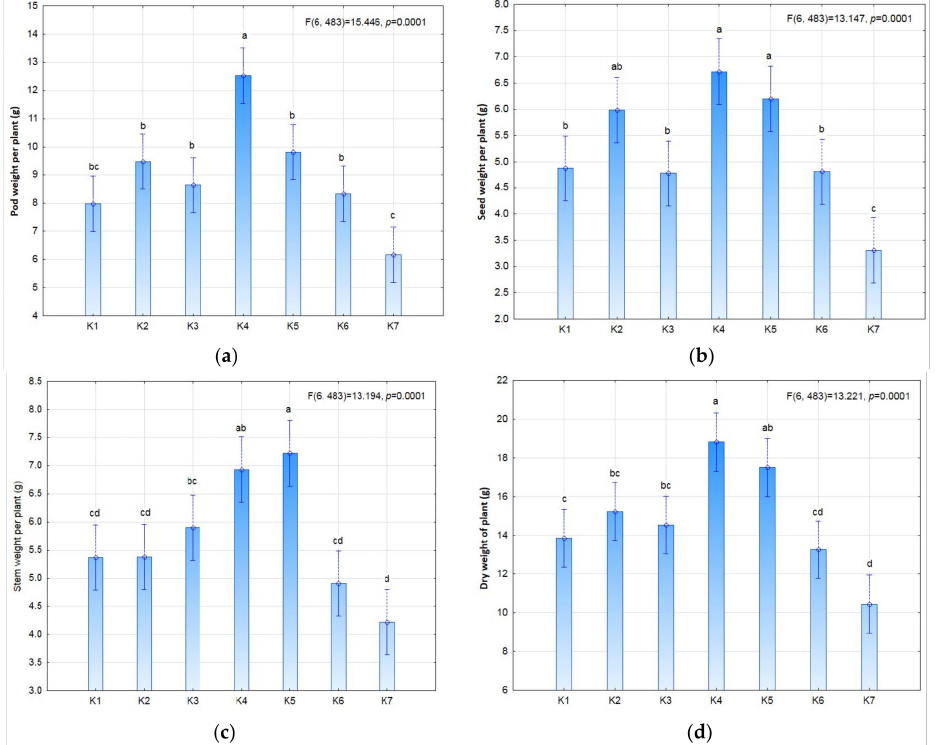
Figure 3. Selected morphological features of soybean ( a ) pod weight per plant; ( b ) seed weight per plant; ( c ) stem weight per plant; ( d ) dry weight of plant) depending on photostimulation treatment. Different letters indicate significant differences between means. Significant effects at p <